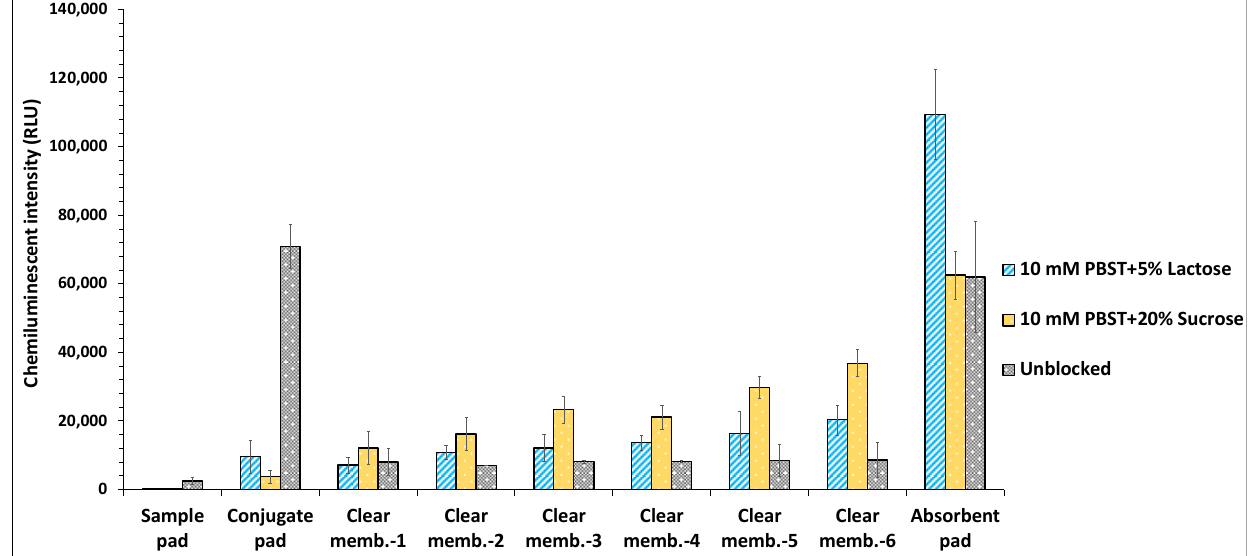
Figure 4. Effect of conjugate pad blocking on the release of capture